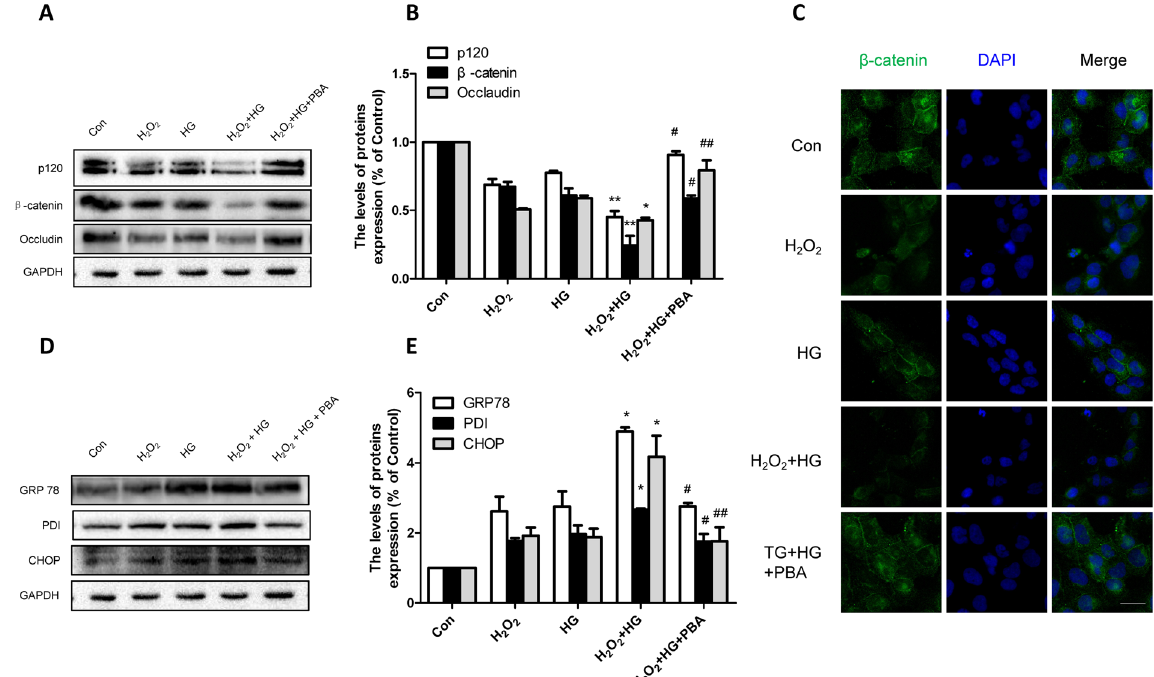
Figure 9. Inhibiting ER stress ameliorates H 2 O 2 + HG induced loss of TJ and AJ proteins in vitro . ( A – D ) Western blot and quantification of p120, β -catenin and Occludin in each group. ( E ) Immunofluorescence staining of β -catenin in each group. Scale bar = 10 μ m. ( E , F ) Western blot and quantification of GRP78, PDI and CHOP in each group. * p < 0.05, ** p < 0.01 vs H 2 O 2 group, # p < 0.05, ## p < 0.01 vs H 2 O 2 + HG group. All experiments were performed three times at